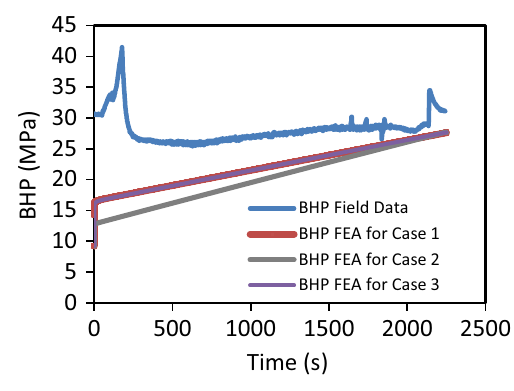
Fig. 2 Field bottom-hole injection pressure and FEA predicted